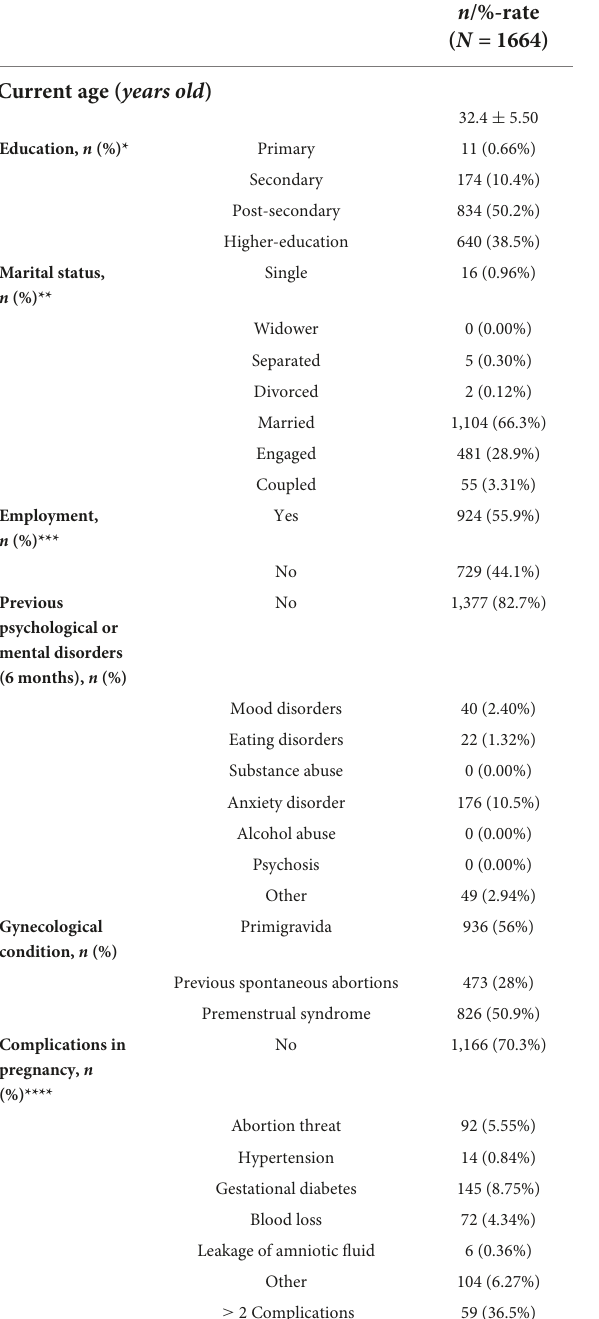
TABLE 2 Socio- demographic and clinical characteristics at intake (T0; N = 1664).